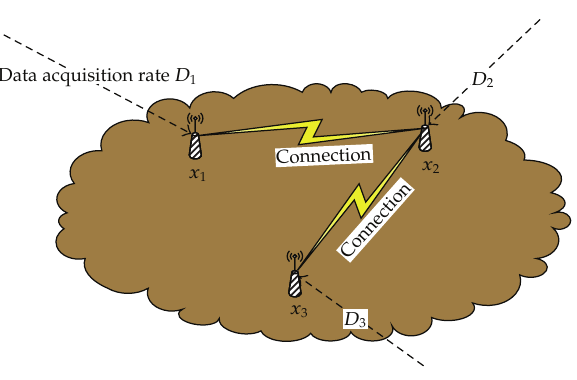
Figure 1: Wireless sensor